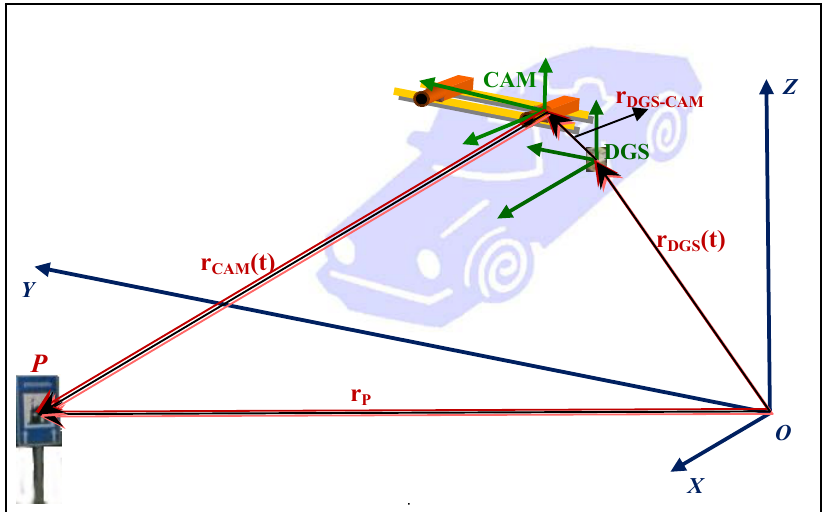
Figure 7. Scheme of point georeferencing in a